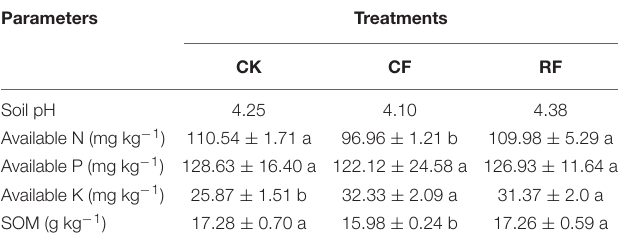
TABLE 1 | The physical and chemical nature of the rhizospheric soil.